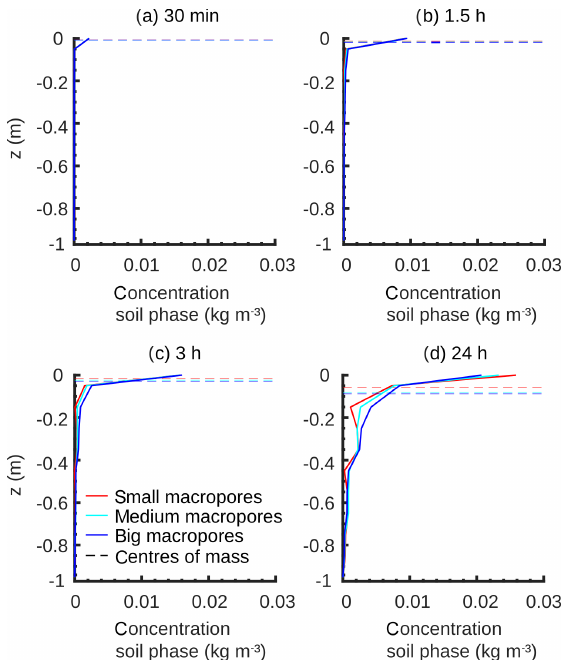
Figure A2. Time series of bromide tracer concentration profiles and centres of mass at different macropore diameters (dmac) during the rainfall event (a, b) , shortly after it (c) and at the end of simula- tion (d)